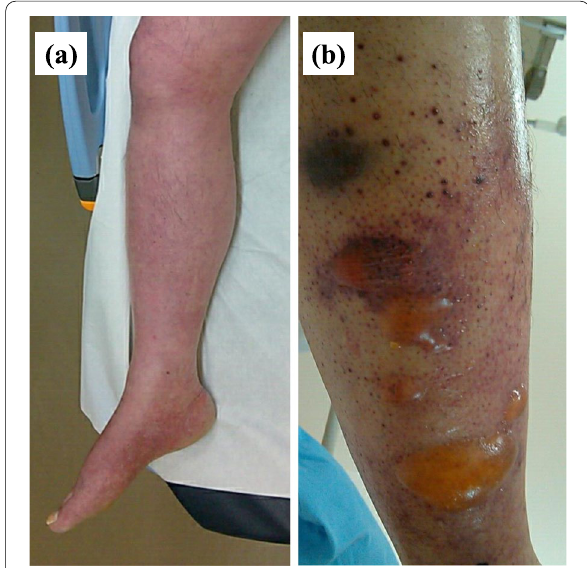
Fig. 1 Clinical appearance of the right lower leg. a Redness and edema were present on day 1. b The redness and edema worsened with blister formation on day 4